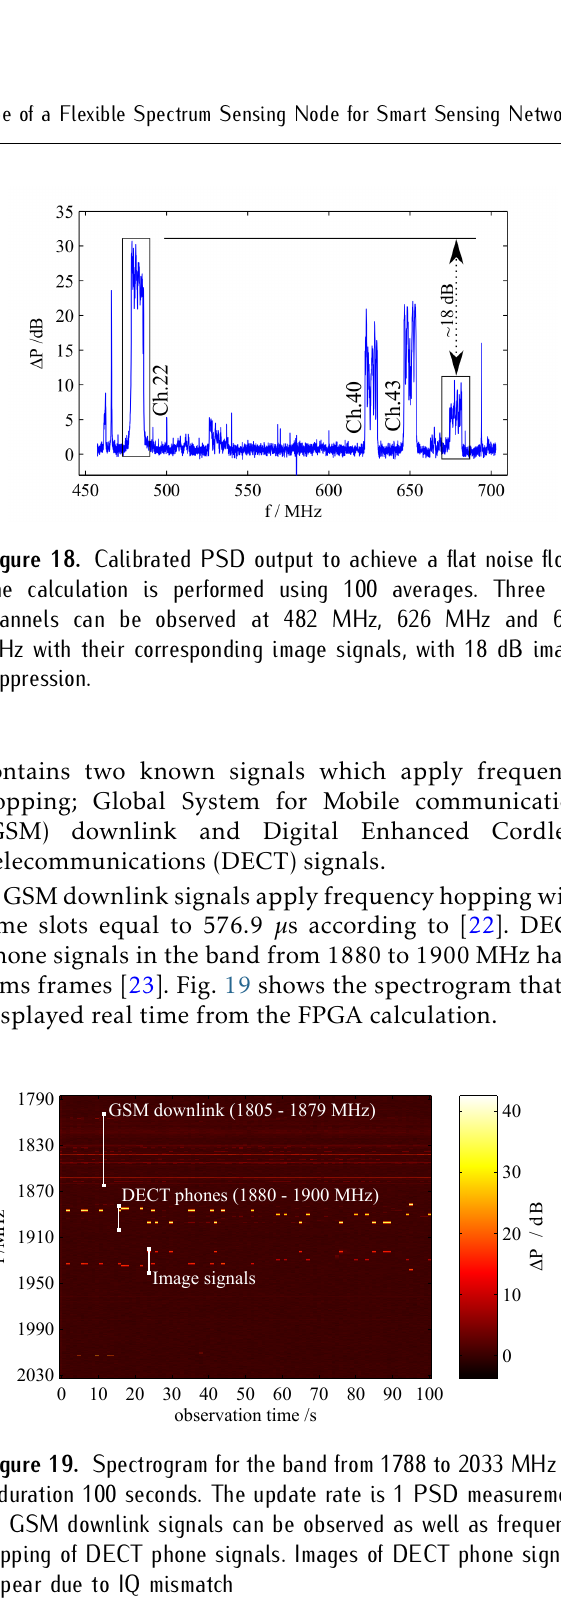
Figure 19. Spectrogram for the band from 1788 to 2033 MHz for a duration 100 seconds. The update rate is 1 PSD measurement /s. GSM downlink signals can be observed as well as frequency hopping of DECT phone signals. Images of DECT phone signals appear due to IQ mismatch The detection time here is 1.76 ms for N avg = 100. The frequency hopping of DECT signals can be distinguished more clearly than GSM downlink signals which exhibit faster changes. Image signals from high power DECT signals can also be seen approx. 18 dB below the corresponding signal